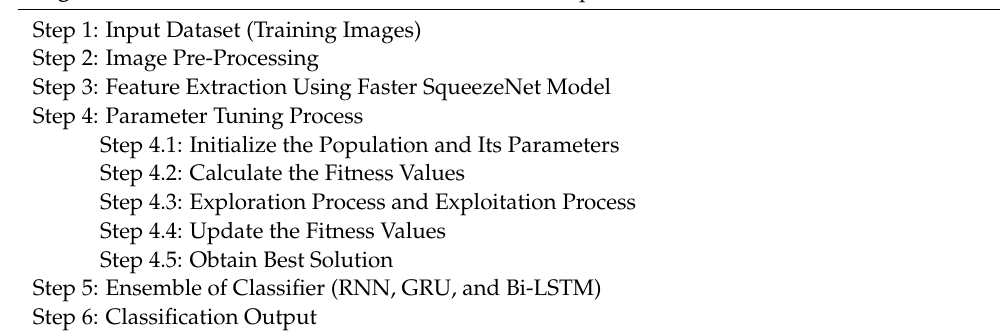
Algorithm 1 : Process Involved in AAOXAI-CD Technique